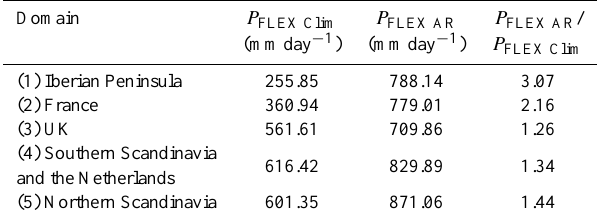
Table 5. The contribution of the different moisture sources to the precipitation derived from FLEXPART, computed as E − P < 0 ( P FLEX ), over the five analysed domains for the climatological pe- riod ( P FLEX Clim ) and for the AR days ( P FLEX AR ). The ratio be- tween the two is also